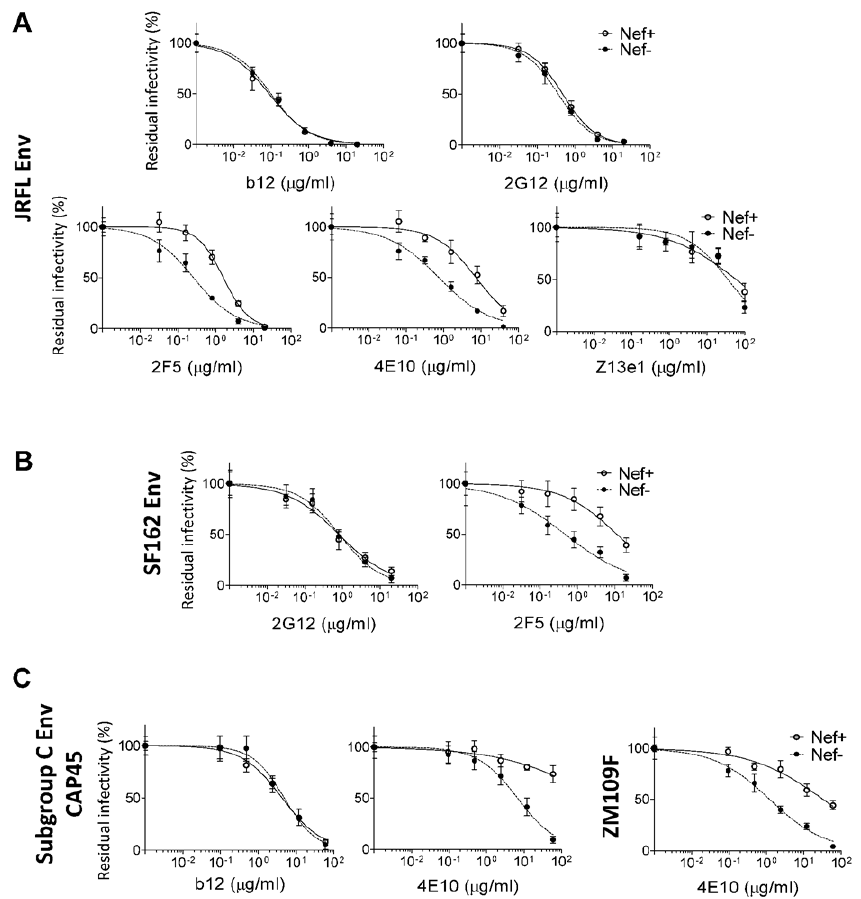
Figure 3. Virus particles pseudotyped with Env Glycoproteins derived from diverse HIV-1 isolates are responsive to the Nef effect on the susceptibility to 2F5 and 4E10. Neutralization of Nef-positive and Nef-defective HIV-1 NL4-3 virus particles pseudotyped with Env glycoproteins derived from HIV-1 JRFL (A), from HIV-1 SF162 (B) and from two HIV-1 subgroup C isolates (C). Neutralization was performed three times independently. Shown are the mean values and SD.